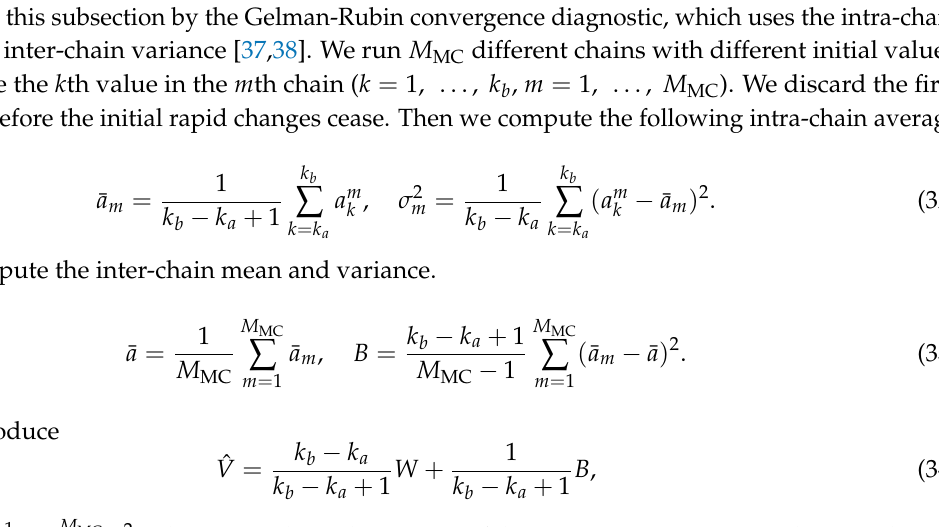
are marked by vertical t